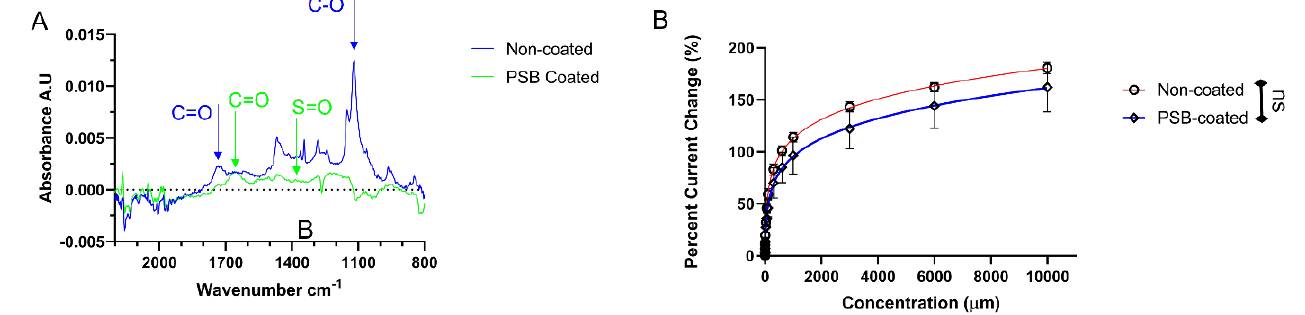
Figure 4. PSB coating characterization with FTIR and calibration curves. Pre-synthesized PSB polymers were dissolved in 10 mM Tris buffer and the aptamer functionalized MEAs were submerged in PSB solution for 2 h at room temperature. ( A ) FTIR spectrum of PSB coating. A Au coated 1 cm × 0.5 cm Si wafer was used for FTIR characterization of the coating. The blue arrow indicates characteristic peaks of C-O (1085 – 1050 cm − 1 ) from MCH and C=O (1720 – 1706 cm − 1 ) bond from aptamers. The green arrow indicates C=O (1680 cm −1 ), S=O (1372 – 1335 cm −1 ) from the PSB polymer. ( B ) The calibration curves of non-coated and PSB coated sensors in vitro. The coating did not affect sensors’ sensitivity. Mean ± SD, Modified Langmuir model, n = 6.